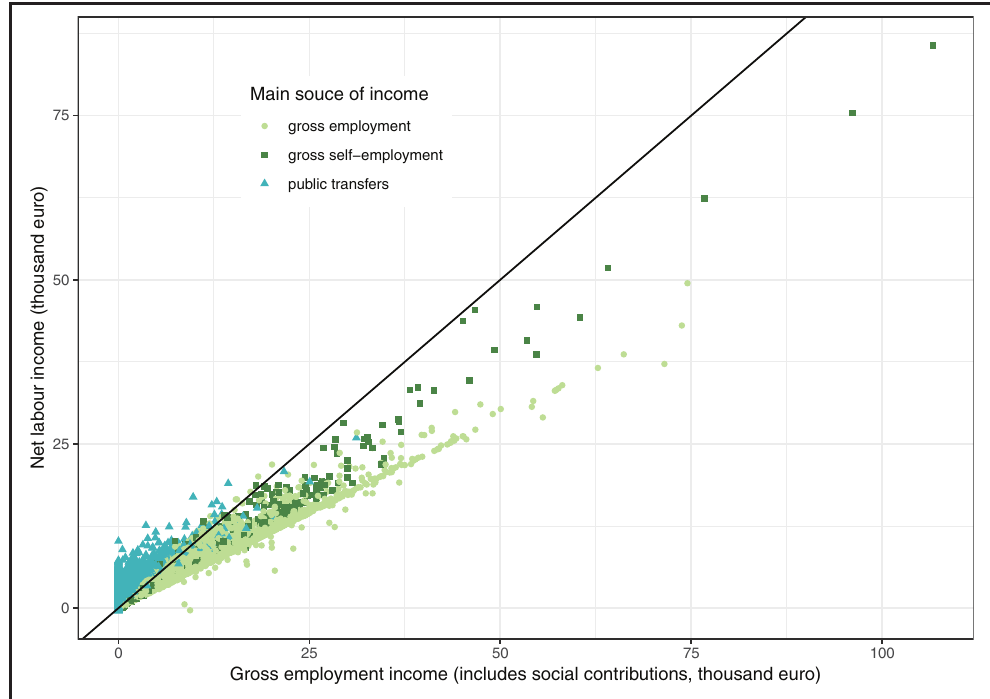
Figure 3 Statutory equivalized incomes of households grouped using the income definition in